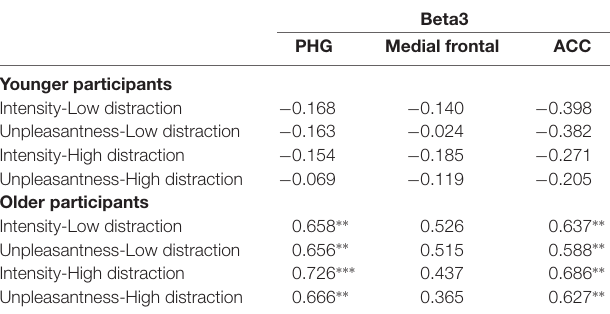
TABLE 3 | Pearson’s correlations between pain ratings and beta3 resting-state EEG current density in both groups. Beta3 PHG Medial frontal ACC